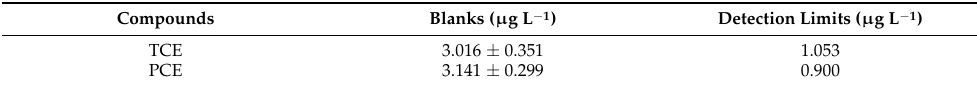
Table 4. Blanks and detection limits of TCE and PCE.